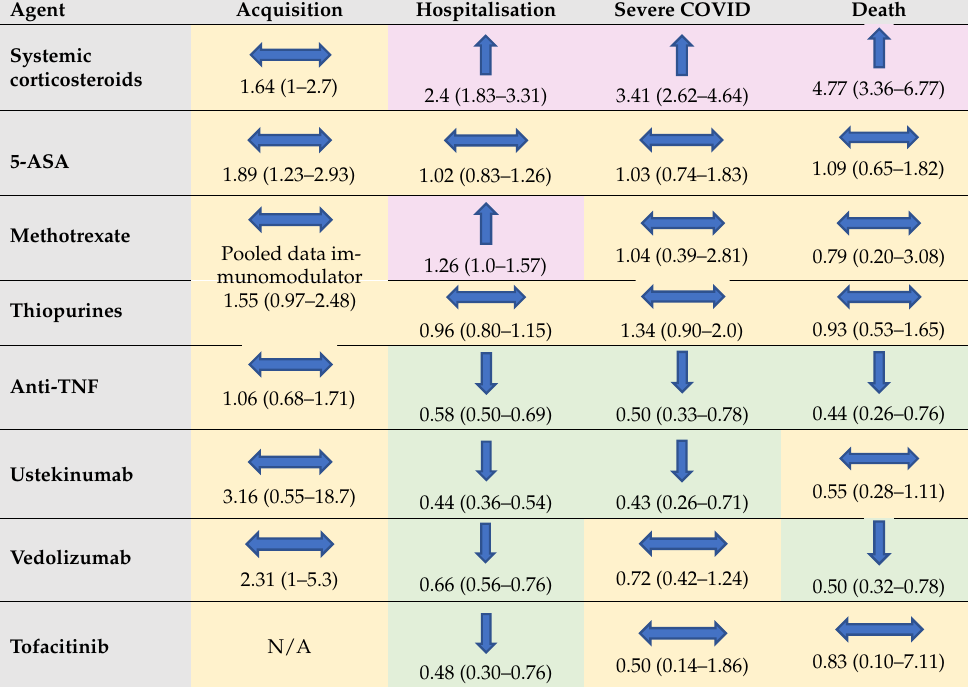
Table 1. Adjusted odds ratios (95% CI) of acquisition and outcomes of COVID-19 infections stratified by medication from [4,7].